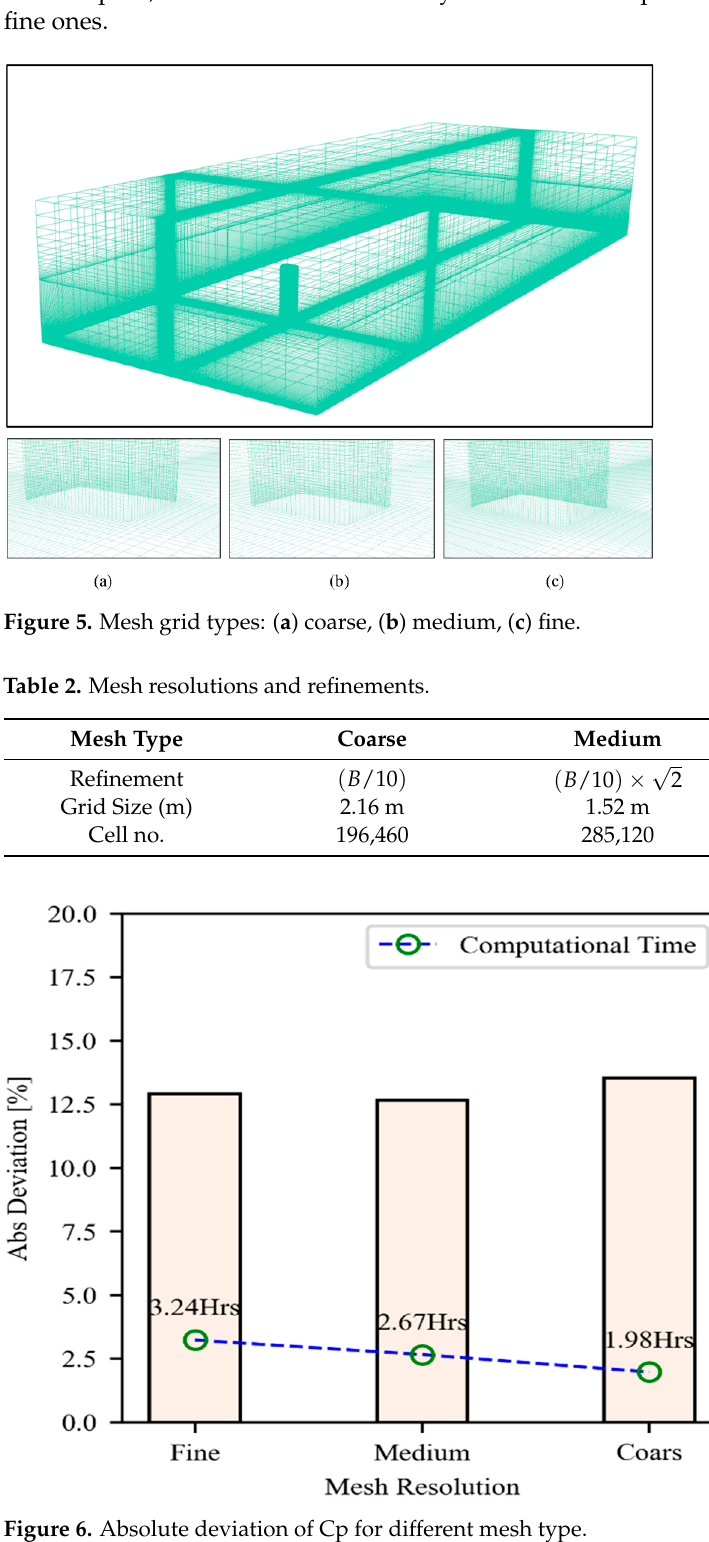
Figure 6. Absolute deviation of Cp for different mesh